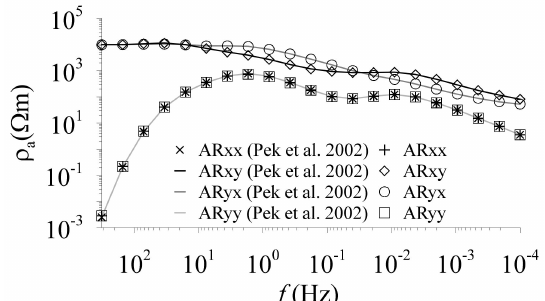
Figure 1. Apparent resistivities for the GSLsz model obtained via the 1-D anisotropic code of Pek and Santos [10] and our 3-D edge-based FE algorithm. The symbols on the left and right column of the legend denote their results and this study, respectively. Twenty-one frequencies were generated within the range of 10 − 4 Hz < f < 320 Hz in terms of logarithmic equivalent space.